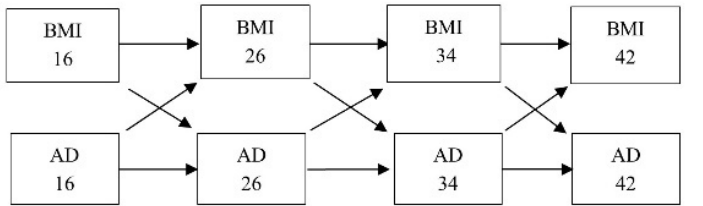
Figure 1. Hypothesized models linking local area deprivation (AD) and body mass index (BMI) across the life course. Model A (area deprivation only) includes only paths from area deprivation to BMI at the next interval, Model B (health selection only) includes only paths from BMI to area dep- rivation at the next interval and Model C includes all paths from Models A and B.